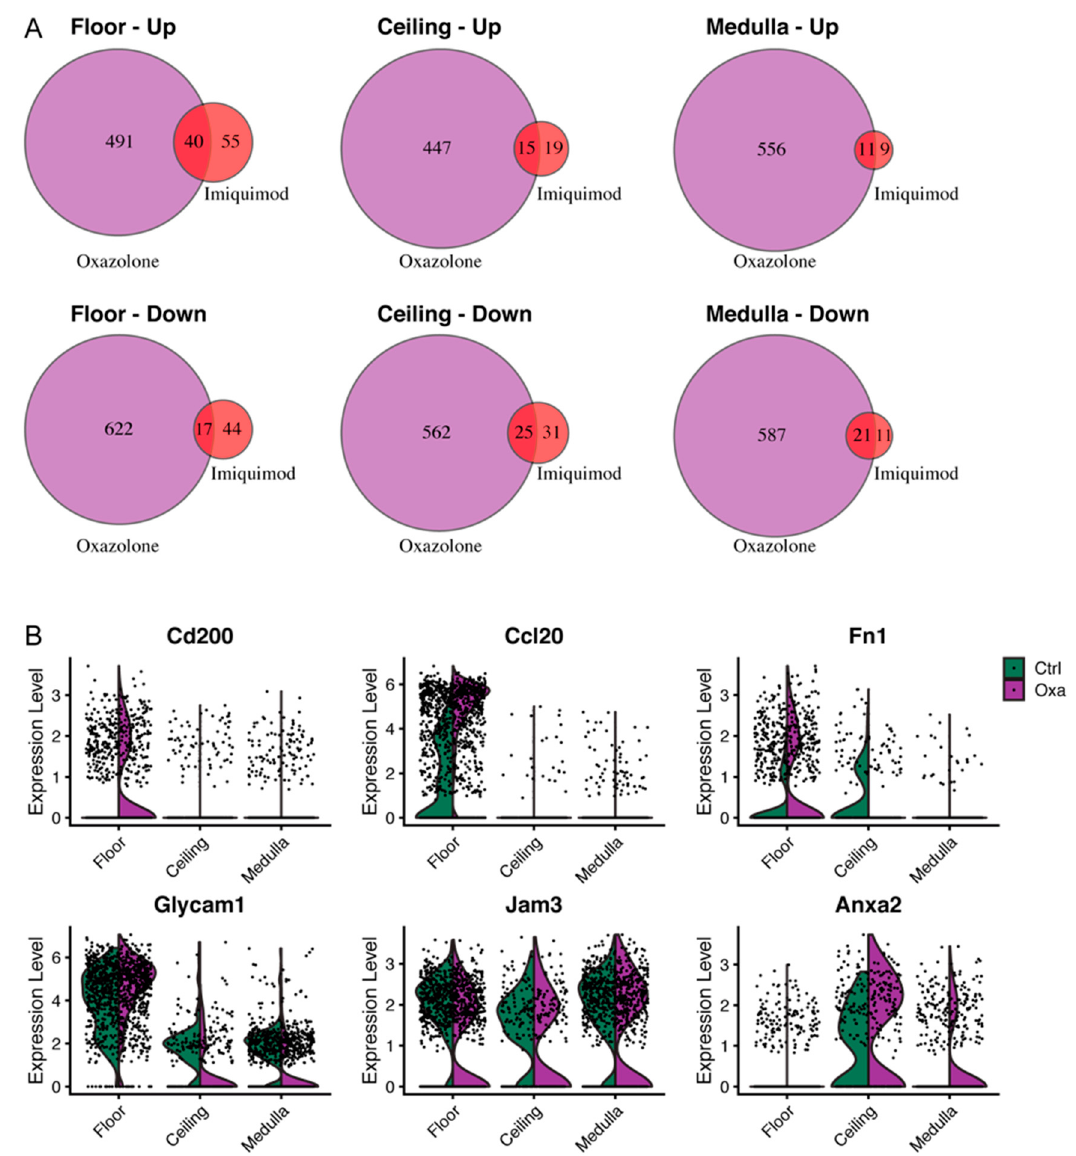
Figure 5. Comparison of dysregulated genes in LN LECs induced by cutaneous oxazolone challenge. ( A ) Overlap of up- or down-regulated genes in different LN LEC subtypes upon inflammation induced by oxazolone or imiquimod. ( B ) Examples of congruently up- ( Cd200 , Ccl20 , Fn1 , Glycam1 ) or down-regulated ( Jam3 ) genes in floor LECs in the oxazolone dataset.